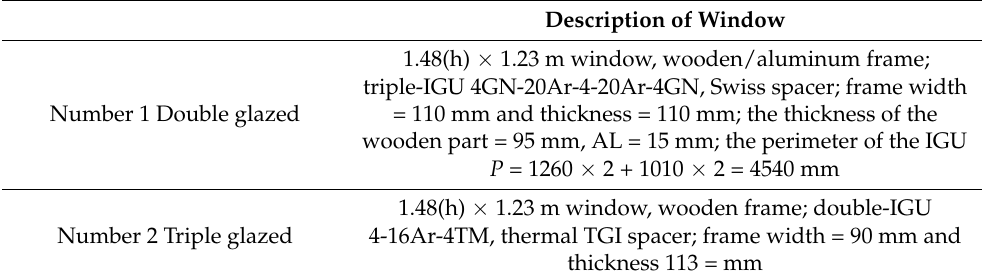
Table 1. Descriptions of the double- and triple-glazed windows measured in the hot box. Description of Window